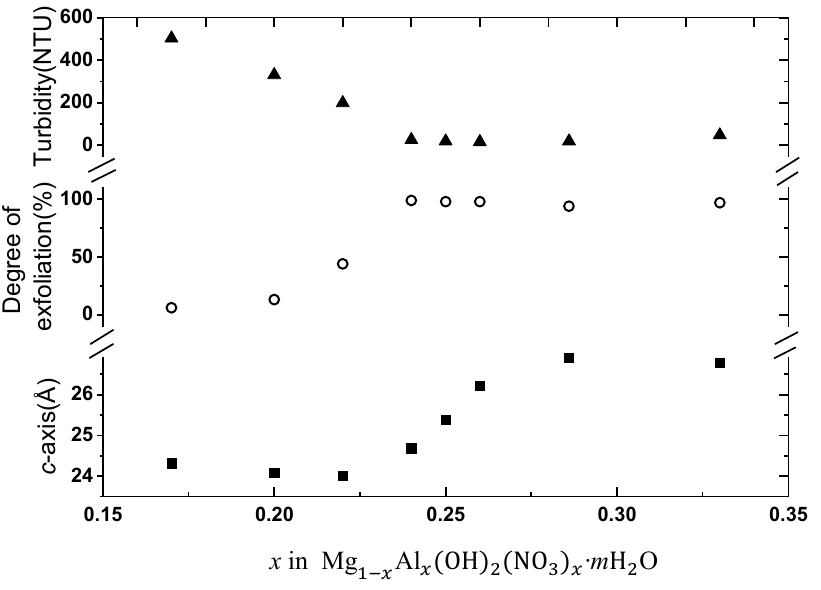
Figure 4. Turbidity ( ▲ ) , degree of exfoliation ( ○ ) , and c ‐ axis ( ) versus Al(III) content x in Mg 1 − x Al x (OH) 2 (NO 3 ) x · m H 2 O.